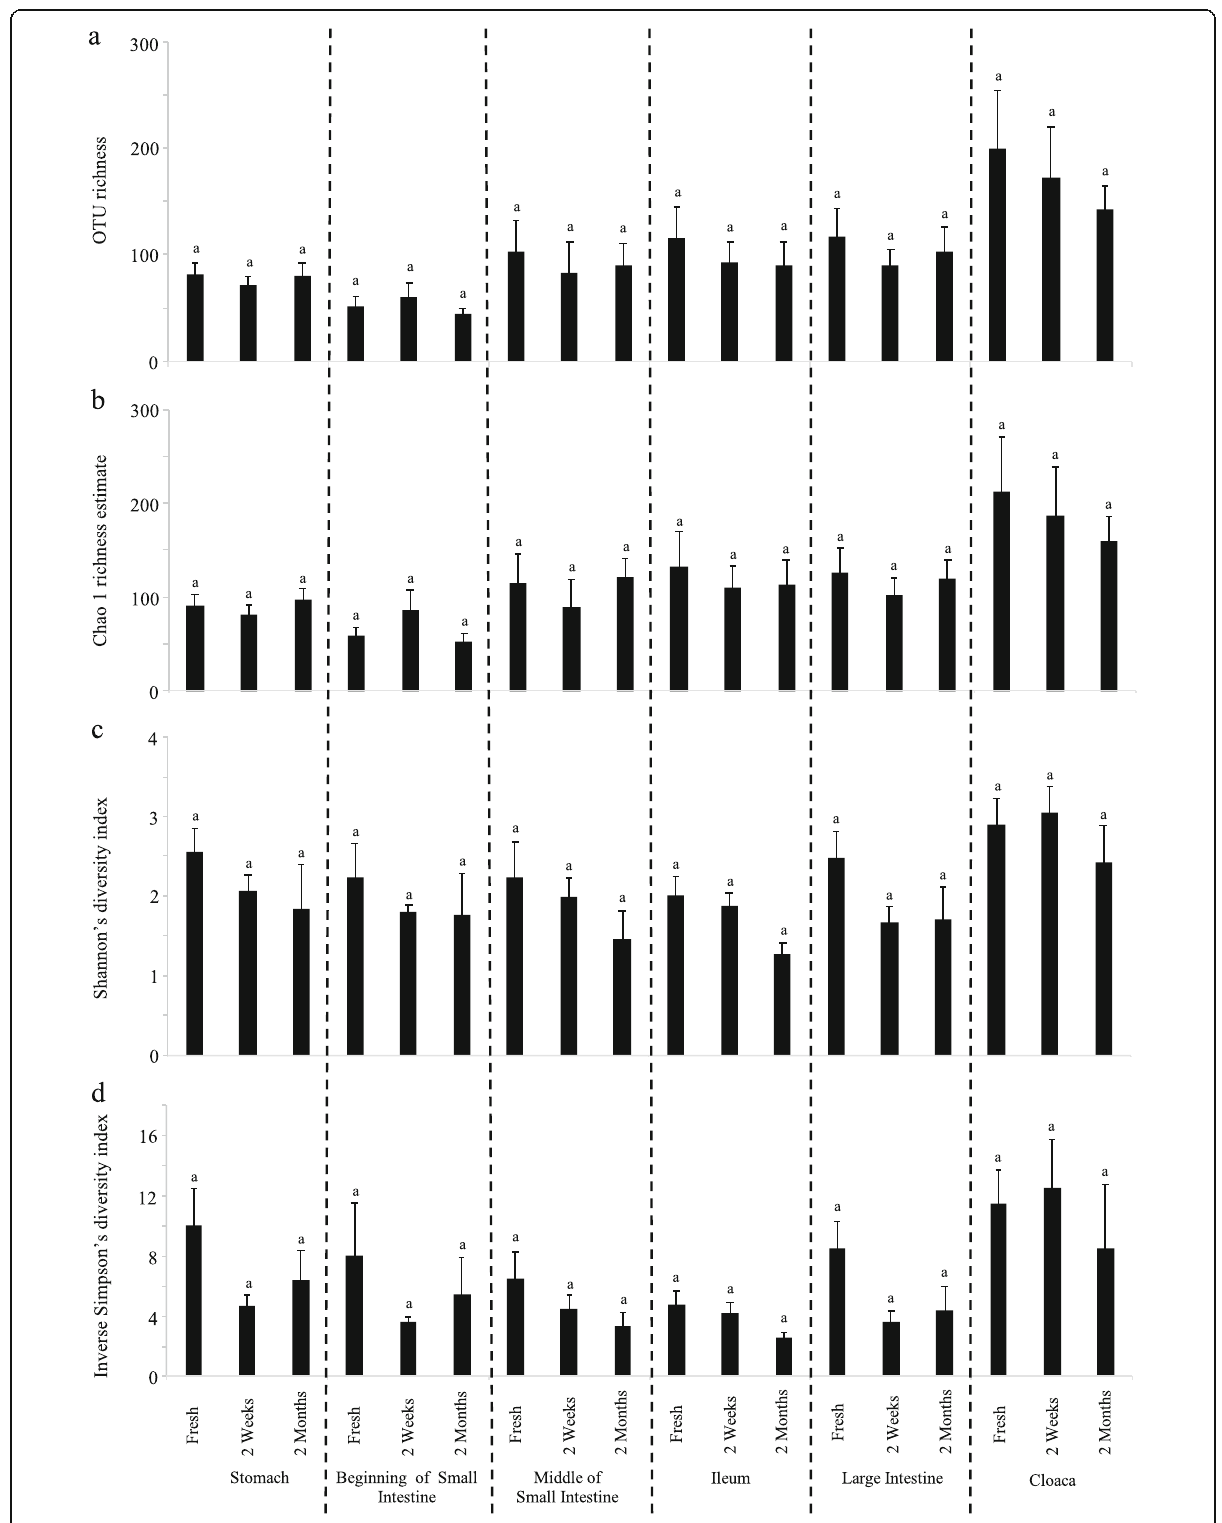
Fig. 4 Average ( a ) OTU richness, ( b ) Chao 1 richness estimates, ( c ) Shannon ’ s diversity index and ( d ) Inverse Simpson ’ s diversity index of different digestive tract regions of fresh, two-weeks old and two-months old alcohol specimens. Letters above bars indicate the results of Tukey post hoc tests with identical letters representing groups that were not significantly